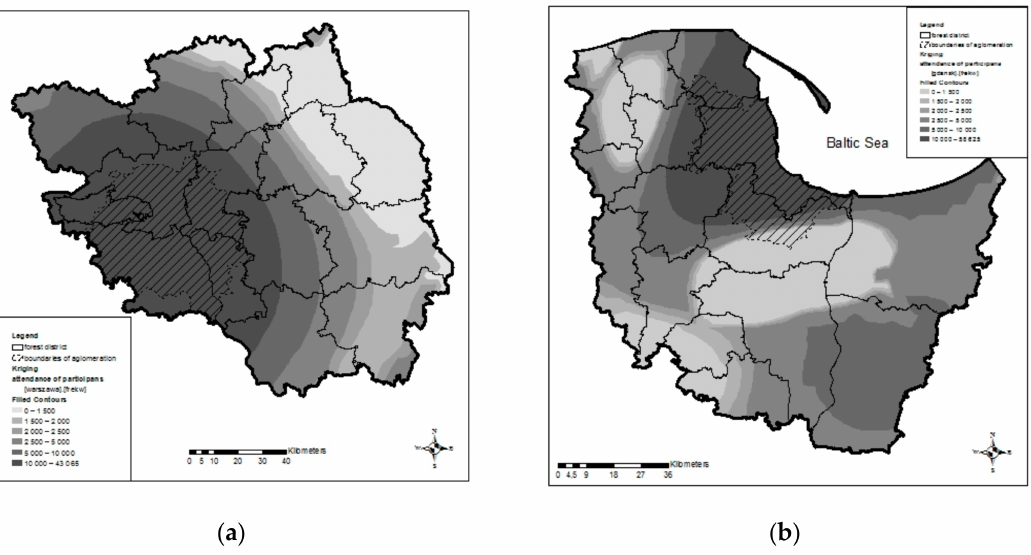
Figure 3. The urban agglomerations of Warsaw ( a ) and Tricity ( b ) and participation at organised forms of physical activity in